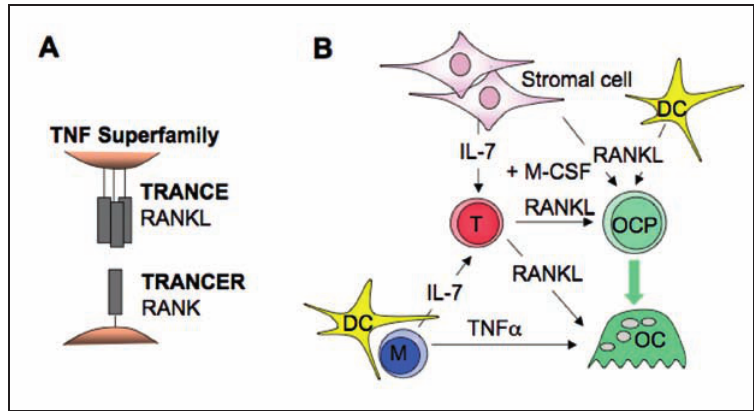
A. Receptor activator of nuclear factor k B ligand (RANKL, also named TRANCE) binds to its receptor RANK (also named TRANCER), a member of the TNF receptor super - family. B. IL-7-driven production of RANKL by T cells increases the pool of osteoclasts either indirectly by differentiation of osteoclast progenitors or directly by osteoclast prolifer- ation. (DC: dendritic cell, M: macrophage, T: T lymphocyte, OCP: osteoclast progenitor, OC: osteoclast, TNF a : tumour necrosis factor a , M-CSF: macrophage colony stimulat- ing